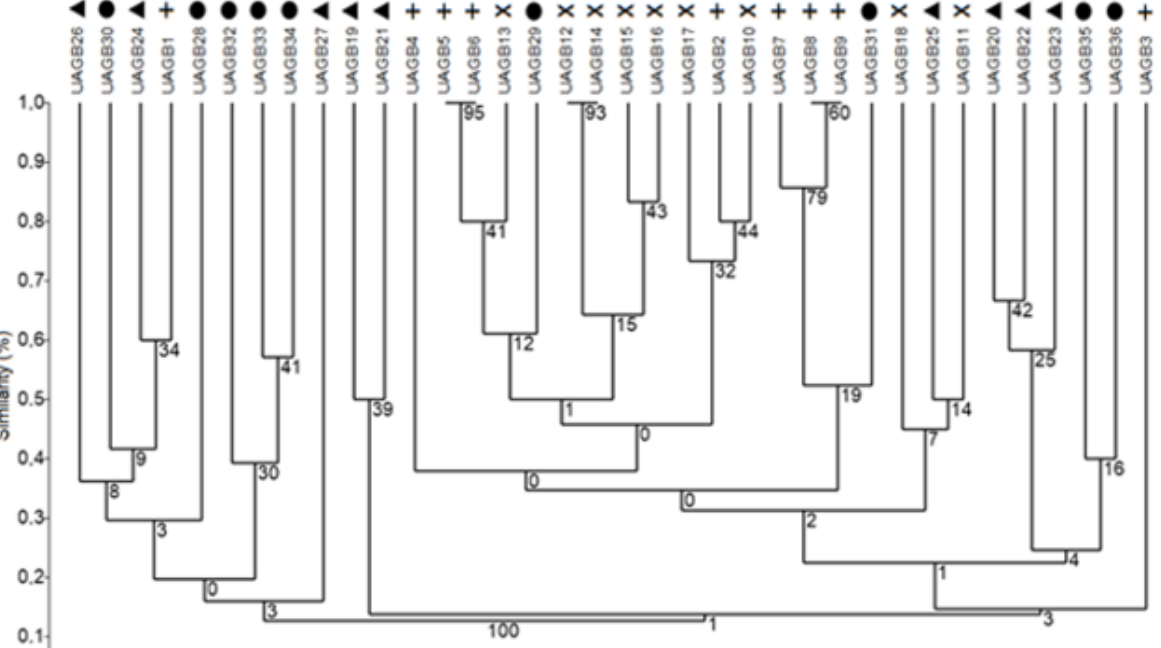
Figure 1. Dendrogram of genetic similarity using BOX gene based on the Jaccard Coefficient and grouped by the algorithm Unweighted Pair-Group Method with Arithmetical Average (UPGMA) of the 36 isolates associated with Brachiaria humidicola (Rendle.) Schweickerdt and Brachiaria decumbens Stapf. from root and rhizospheric niche. + = root niche isolates of B. humidicola ; × = rhizospheric niche isolates of B. humidicola ; ▲ = root niche isolates of B. decumbens ; • = rhizospheric niche isolates of B. decumbens